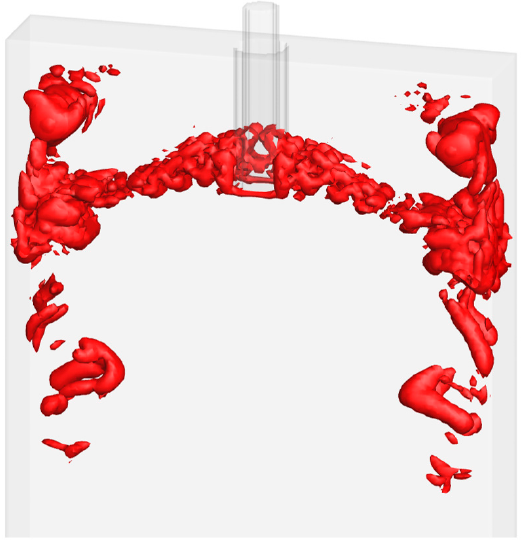
Figure 13. Vortex structures of the upper and lower streams near the wall of the mold formed using the Δ criterion with Δ = 200.